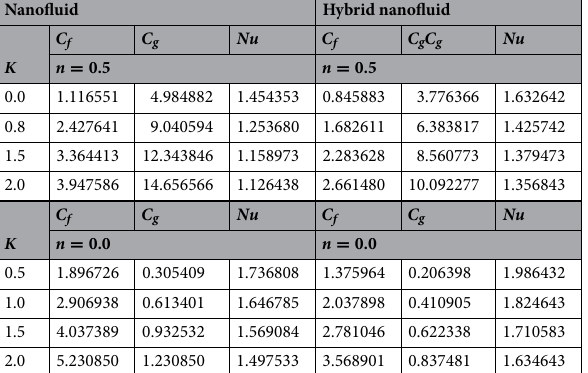
Table 3. Variation in C f , C g and Nu for nanofluid ( Al 2 O 3 ) and hybrid nanofluids ( Al 2 O 3 , Cu ) against different values of K when Pr = 2.36, Re = 15, Ha = 0.3, κ = 0.5 and Ec = 0.001